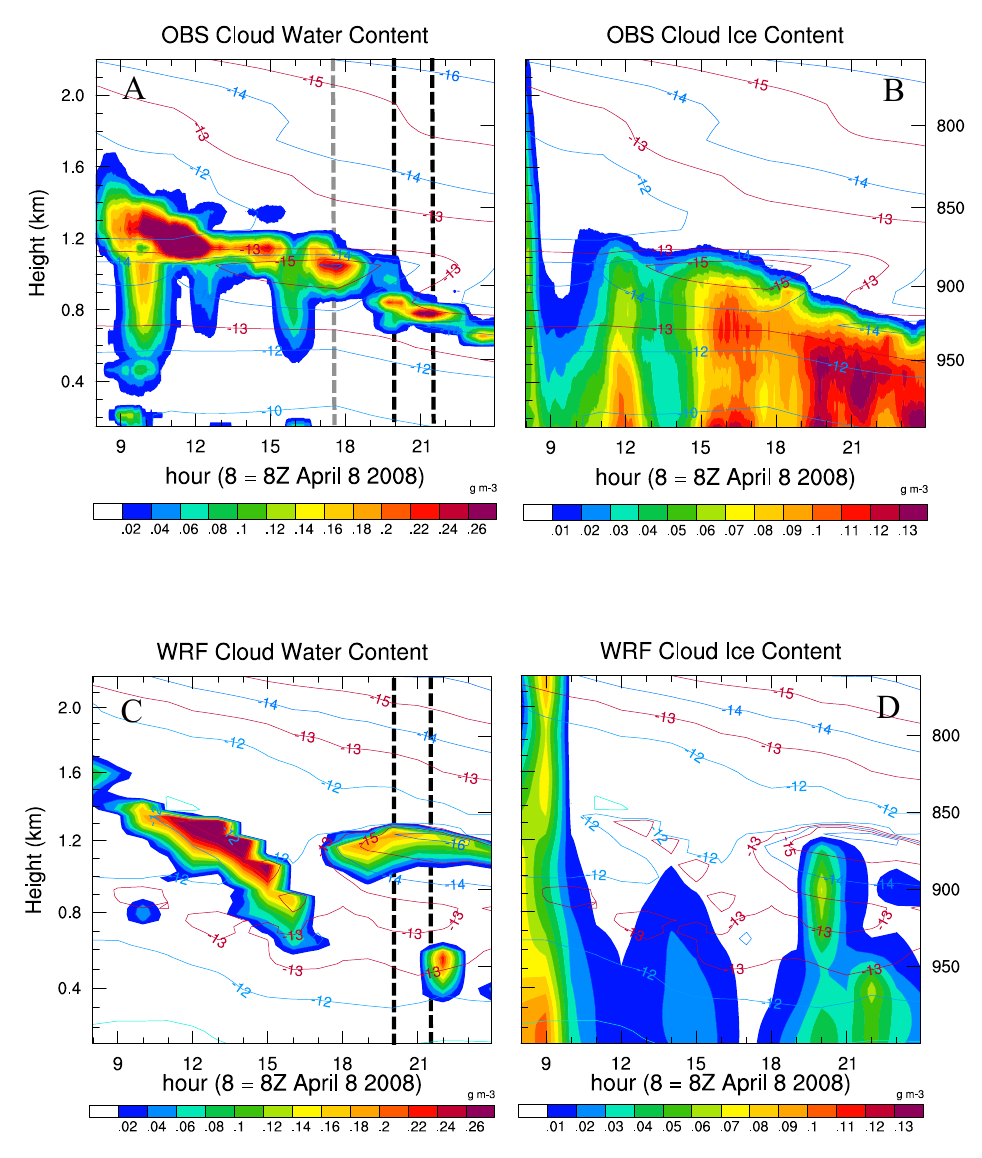
Fig. 3. Observationally retrieved one-hour running mean cloud liquid (A) and ice (B) water content, in gm − 3 , at Barrow, Alaska from 8–24Z 8 April 2008 (color). Hourly output of liquid water (C) and ice (D) from WRF 1km nest. Temperature isopleths ( ◦ C) are interpolated from soundings at 4:22Z 8 April 2008, 17:34Z 8 April 2008, 5:32Z 9 April 2008. Note − 13 ◦ C and − 15 ◦ C contours are red to highlight inversions. Black dashed lines in (A) and (C) indicate the validation period. The gray dashed line in (A) indicates the time of the sounding.